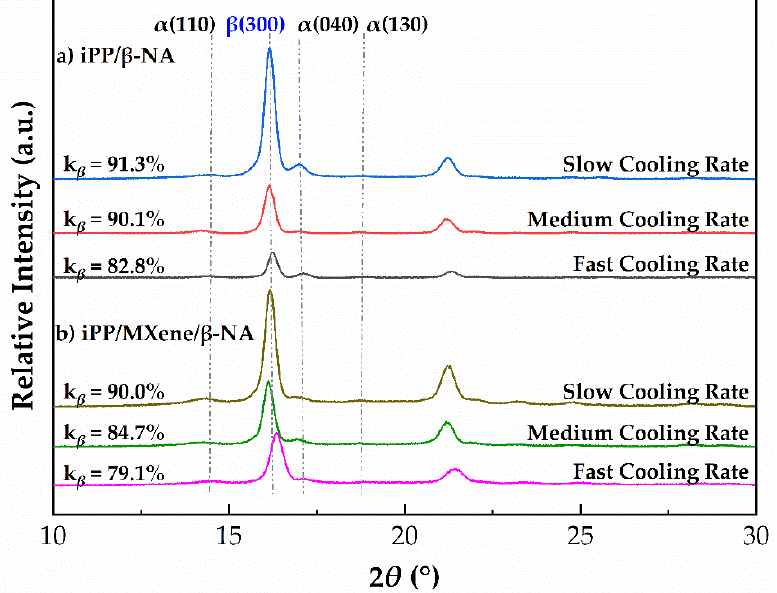
Figure 15. XRD pattern of ( a ) iPP/ β -NA and ( b ) iPP/MXene/ β -NA with different thermal histories.